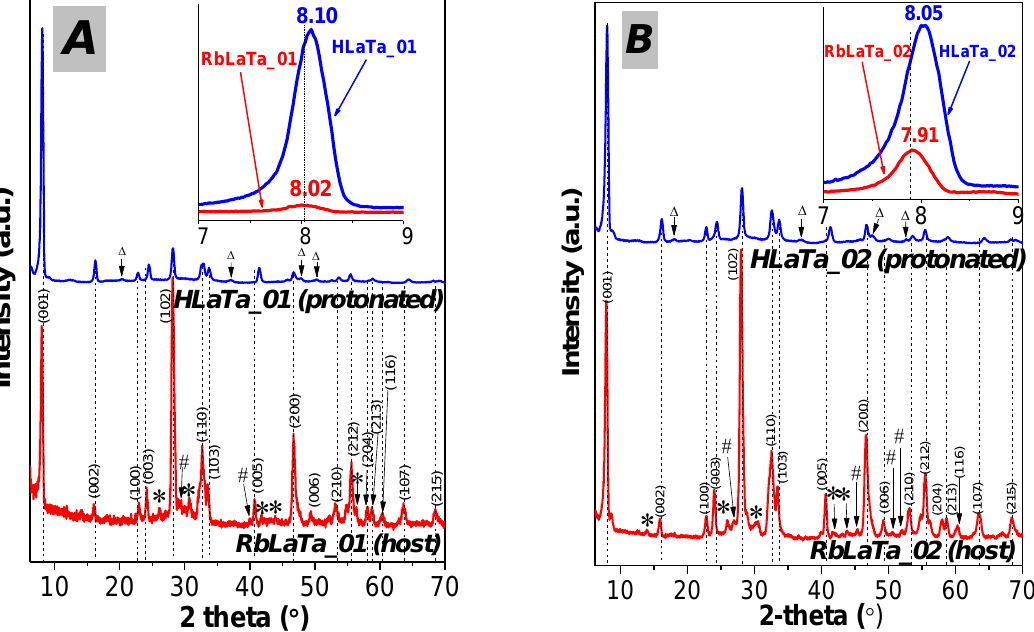
Figure 1. XRD patterns of ( A ) HLaTa_01 and ( B ) HLaTa_02 protonated perovskites. For comparison, both RbLaTa_01(02) hosts are represented. Reprinted with permission from reference [8]. Copyright (2019) Elsevier. Symbols: Δ—Ta 2 O 5 ; *—Rb 2 CO 3 ; #—La 2 O 3 , in brackets are given ( hkl ) Miller index of RbLaTa 2 O 7 phase. Table 1. Synthesis conditions and lattice parameters of HLaTa_01(02) protonated products. For comparison, both RbLaTa_01(02) hosts [8] are given.